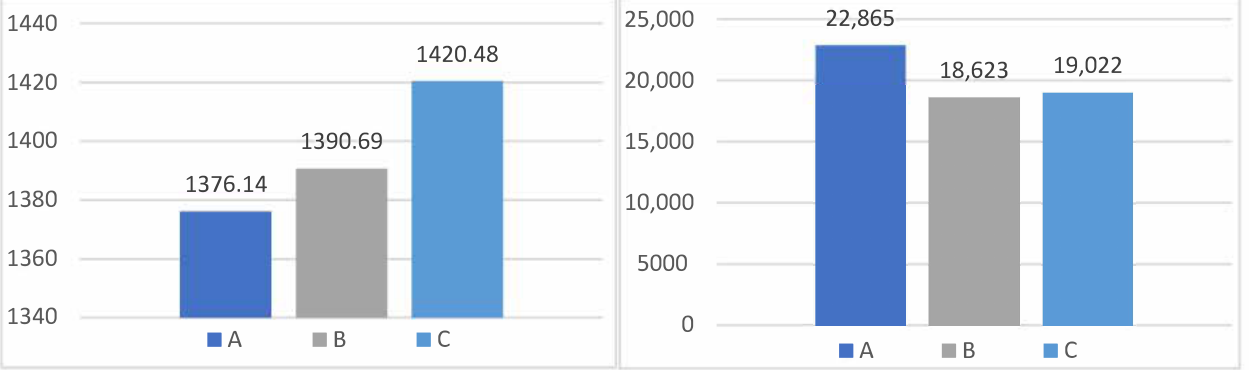
Scheme 1. Left, the total length of the variants A–C, right, the total weight of the variants A–C (authors